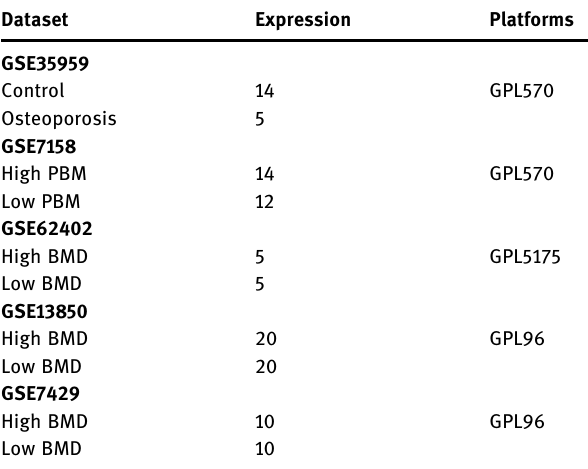
Table 1: Clinical information of the samples